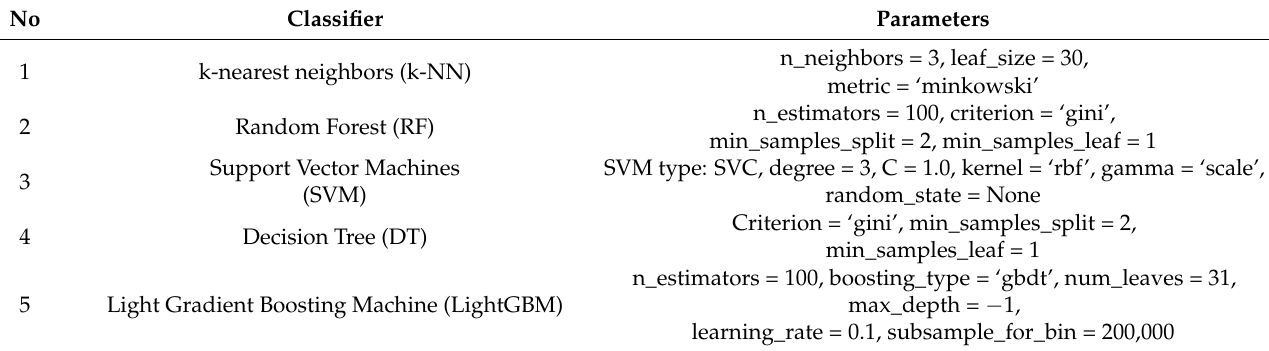
Table 2. Machine learning algorithms’ functional